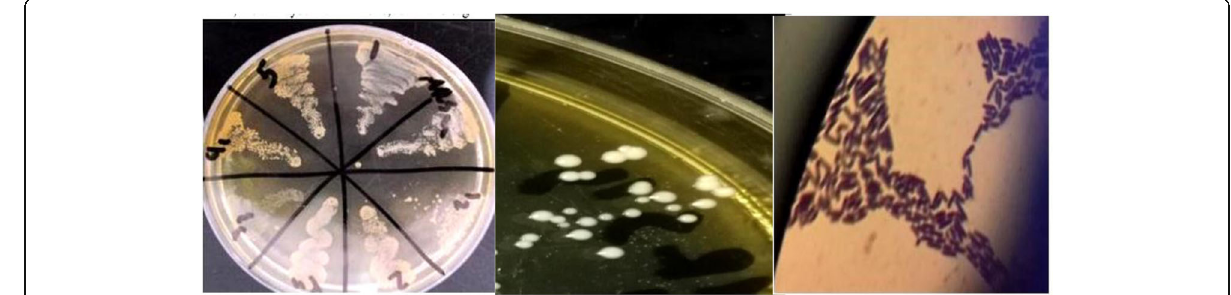
Fig. 1 Morphological and microscopic characters of isolated strain ( Lb . plantarum